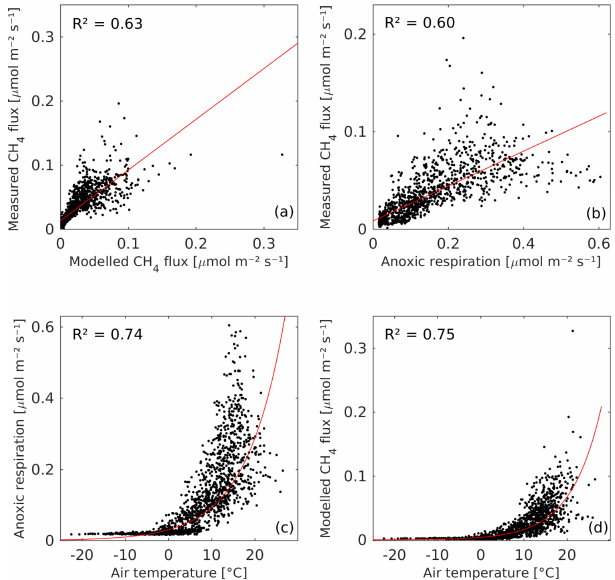
Figure 15. Correlations between (a) modeled and measured CH 4 flux, (b) input anoxic respiration and measured CH 4 flux, (c) ob- served air temperature and input anoxic respiration, and (d) ob- served air temperature and modeled CH 4 flux. The data are from the Siikaneva test (Fig.